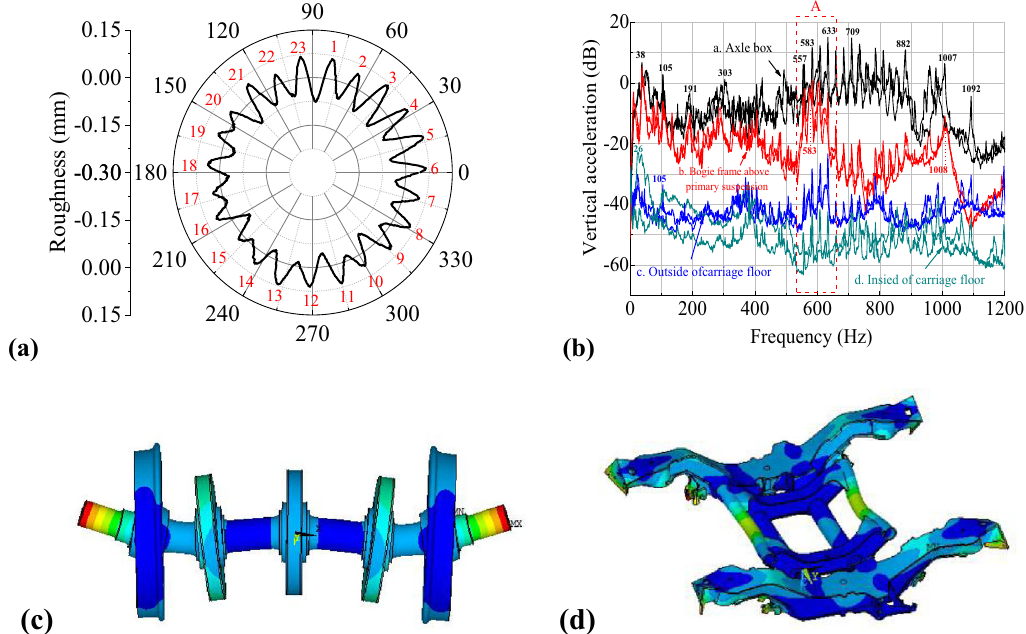
Fig. 18 Causes of wheel polygonal wear of one type of high-speed train [90]: a typical measurement result of wheel polygonal wear; b vibration feature of the axle box, bogie frame, and car body; c eigenmode of the wheelset (589 Hz); and d the eigenmode of the bogie frame (601 Hz) related to the formation of wheel polygonal wear based on the frequency-fixing